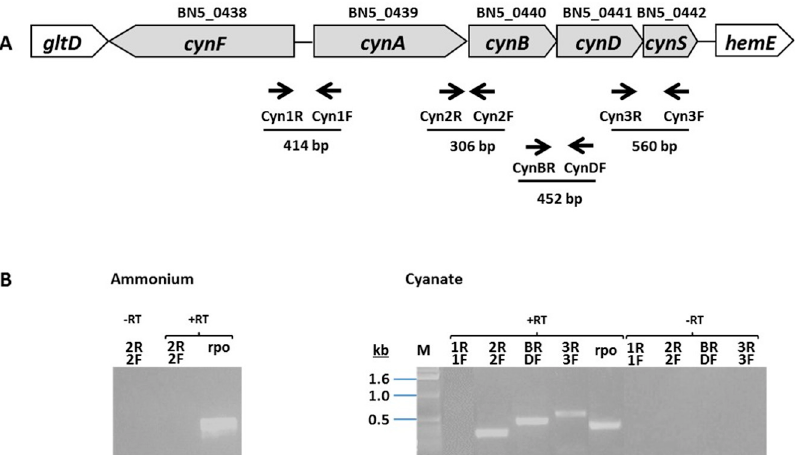
Figure 1. Gene arrangement ( A ) and reverse transcription polymerase chain reaction (RT-PCR) transcriptional analysis ( B ) of the P. pseudoalcaligenes CECT5344 cyn gene cluster. Primer pairs used for the amplification reactions (Table S2, Supplementary Materials) are shown, but not drawn to scale.